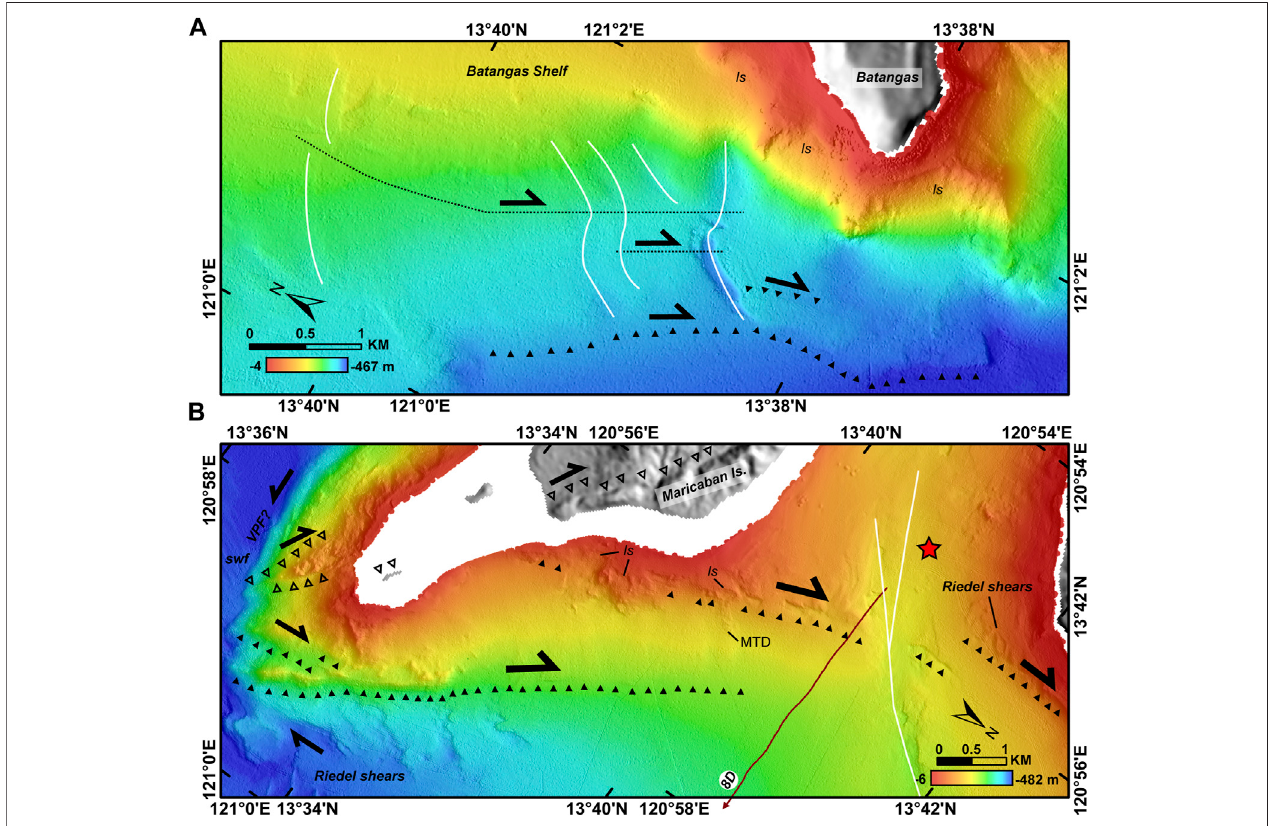
FIGURE7| CloseupoftheBatangasBayFaultSystem(BBFS). (A) ThenortheastfaultsofBBFS.Blackarrowheadspointtoscarps.Brokenblacklinesindicatethe displacement along gullies. (B) The southwest faults of BBFS. Filled black arrowheads point to BBFS. Outlined black arrowheads indicate northwest-trending faults cutting through Maricaban Islands. These could be related to BBFS. Black half arrows show the direction of interpreted fault motion. Subbottom pro fi le is in maroon. White lines indicate gullies. The epicenter of the 2017 earthquake is shown as a red star. Please refer to Figure 6 for the location of the fi gures. ls, landslide scarp; MTD, mass transport deposit; swf, sediment wave fi